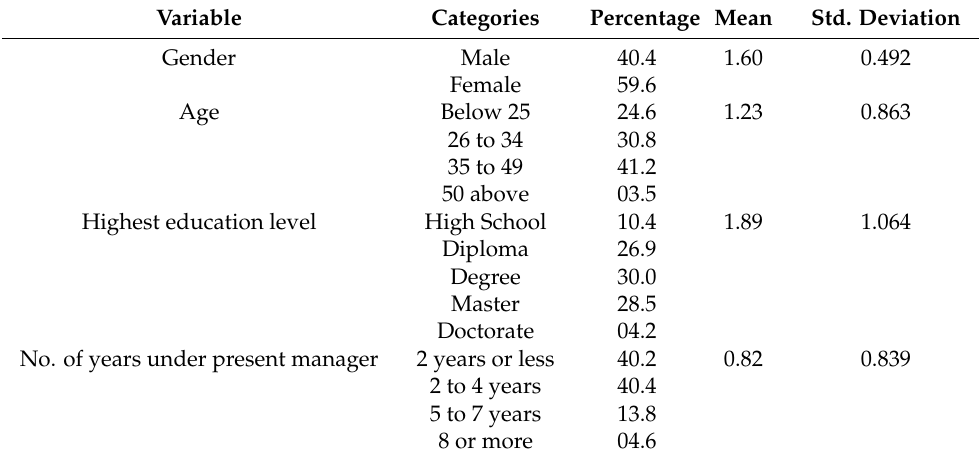
Table 2. Demographic profile of the study ( n =